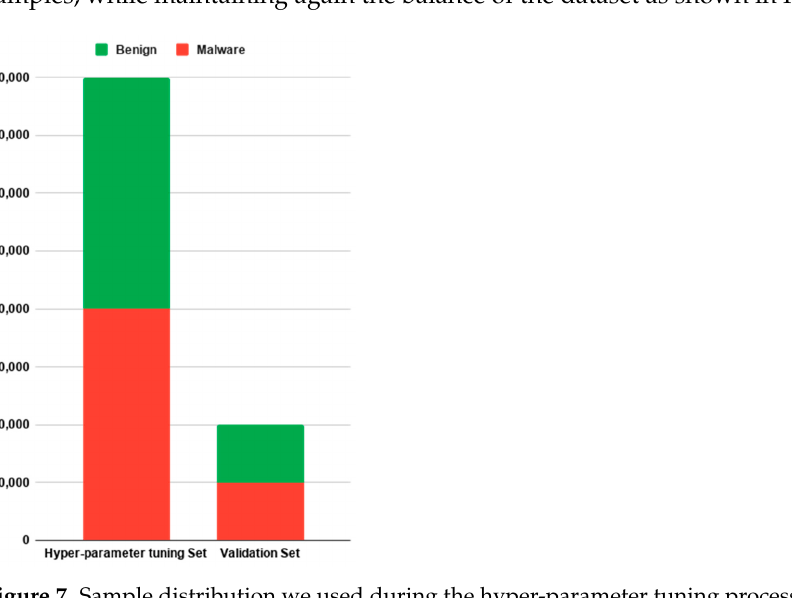
Figure 7. Sample distribution we used during the hyper-parameter tuning process. Table 3. Optimal hyper-parameters of the model.